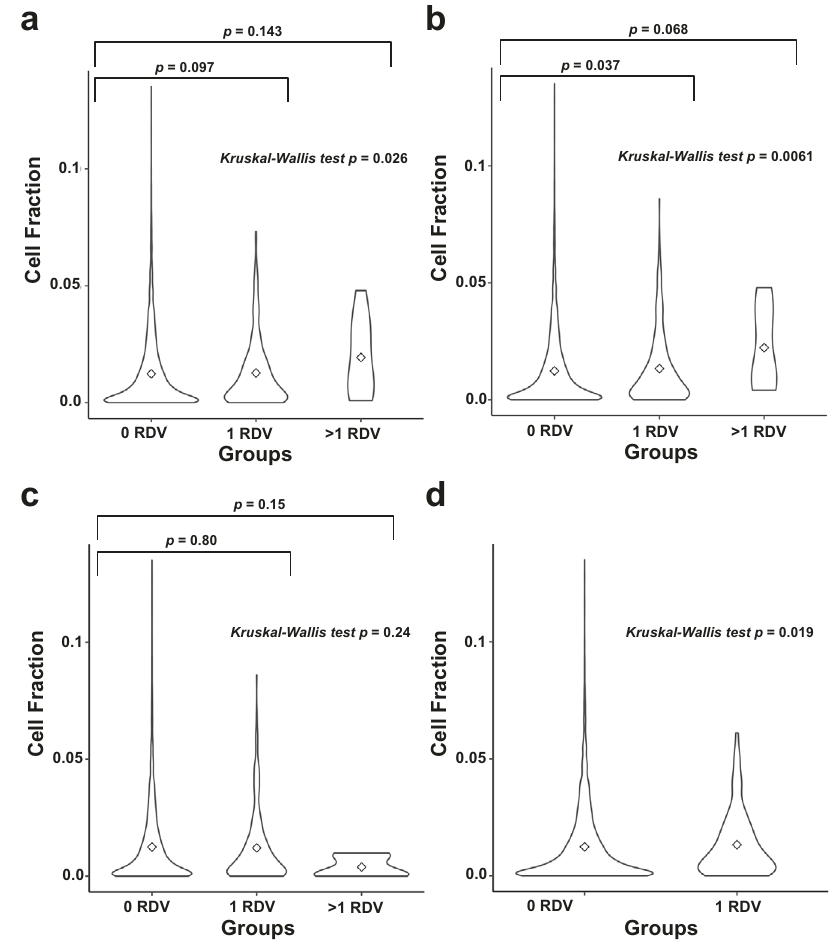
Fig. 6 Comparison of M1 macrophages cell fraction in tumor based on germline RDV load in TCGA cases. a Cancer predisposition genes b DNA damage repair genes c Somatic cancer driver genes d Fanconi Anemia genes. The marker in the violin plot indicates